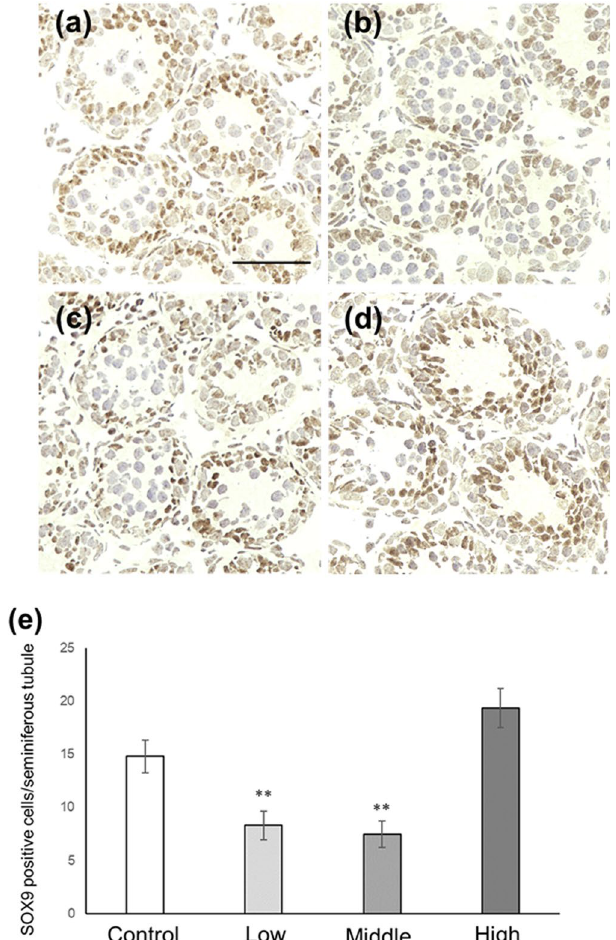
Figure 6. Number of SOX-9-positive Sertoli cells in CORT-administered mice on PND 10. Representative micrographs of Sertoli cells immunostained with anti-SOX-9 antibody in the testes from control ( a ), low-dosed ( b ), middle-dosed ( c ), and high-dosed-CORT mice ( d ) on PND 10. The scale bar is 50 µm. SOX-9-positive cells per seminiferous tubule among the control and CORT mice ( e ). Values are expressed as the mean ± S.E.M of data from 10 animals per group (10 seminiferous tubules per animal). **p < 0.01 compared to the